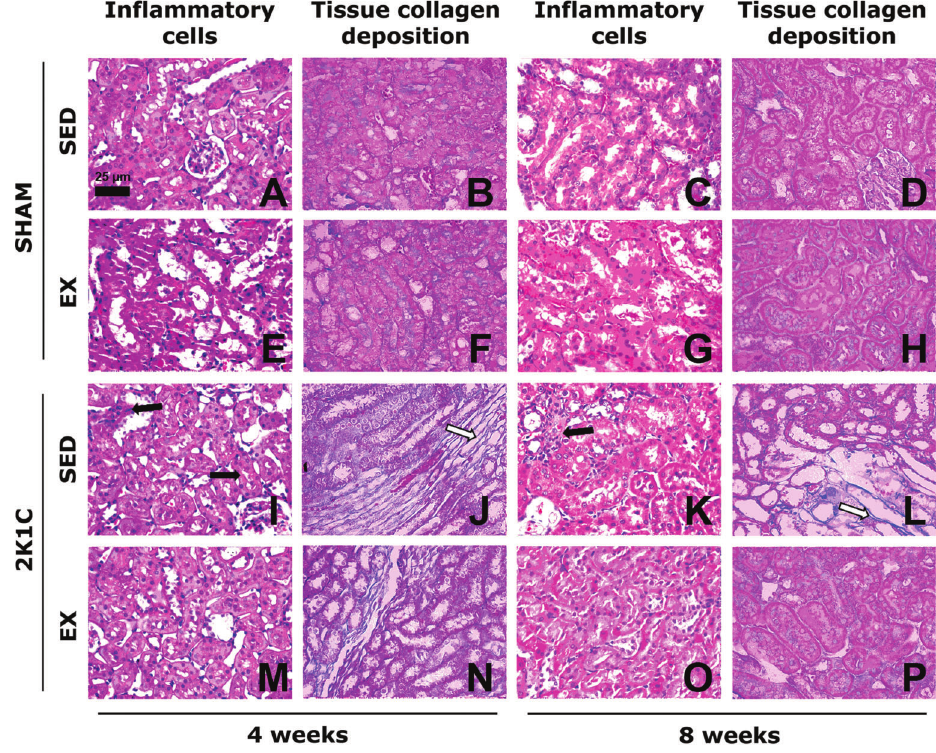
Figure 6. Photomicrographs of the left kidney of normotensive (SHAM) rats and hypertensive (2K1C) rats, either sedentary (SED) or subjected to physical exercise training (Ex, swimming) for 4 and 8 weeks. The number of in fl ammatory cells is consistent with the framework of normality in SHAM SED rats ( A and C ). The in fl ammatory process (black arrows) observed in the left kidney in SHAM Ex rats at week 8 ( G ), 2K1C SED rats ( I and K ), and 2K1C Ex rats ( M and O ) is similar to the normal pattern observed in SHAM SED rats. Note the area with collagen deposition compatible with normality in SHAM SED rats ( B and D ). Note the large area of collagen deposition (white arrows) in 2K1C rats ( J and L ) and small area of collagen deposition in 2K1C Ex rats at week 4 ( N ); however, at week 8, the area of collagen deposition in 2K1C Ex rats resembled the normal pattern of SHAM SED rats ( P ). A , E , I , M , C , G , K , and O are stained with hematoxylin and eosin. B , F , J , N , D , H , L , and P are stained with Masson trichrome. All photomicrographs are magni fi ed to 440 (cid:1) (bar=25 m